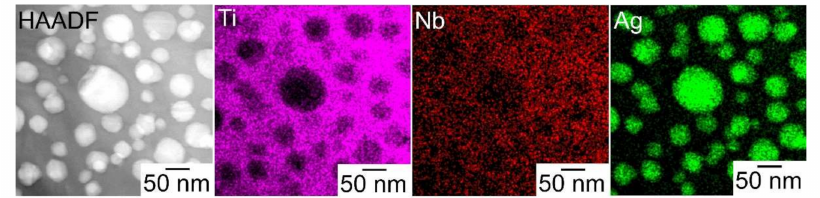
Figure 10. STEM-HAADF image and STEM-EDS elemental mapping of the rapidly-solidified melt-spun ribbons in the Ti 53.4 Ag 33.3 Nb 13.3 alloy. STEM-EDS analysis results of the rapidly-solidified melt-spun ribbons in the Ti 53.4 Ag 33.3 Nb 13.3 alloy. Regions Ti Ag Nb Matrix 75.4 9.6 15.0 Globules 6.9 92.4